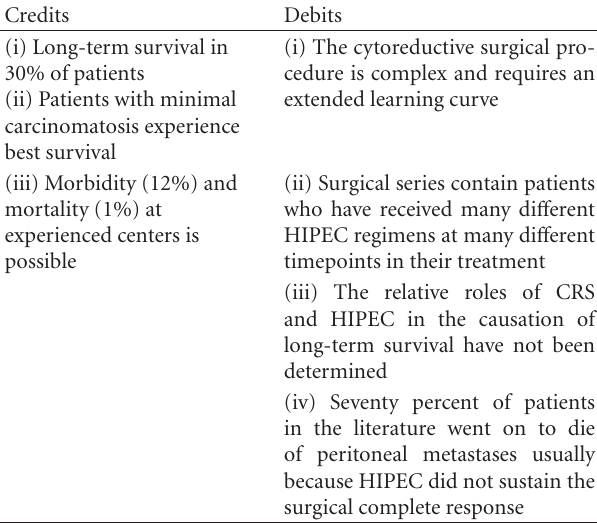
Table 1: Cytoreductive surgery (CRS) and hyperthermic perioper- ative chemotherapy (HIPEC) for colorectal peritoneal